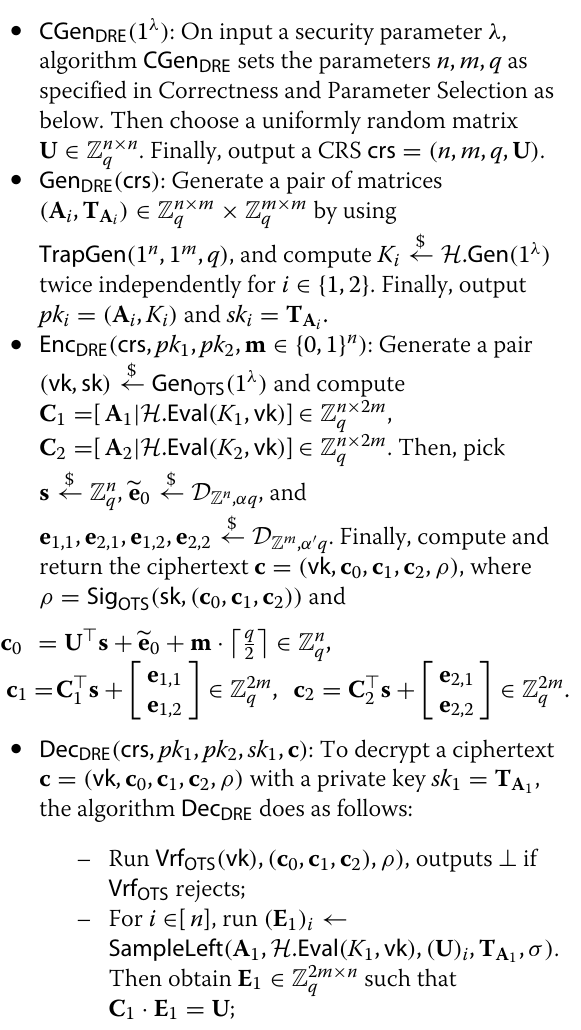
algorithm CGen DRE sets the parameters n , m , q as specified in Correctness and Parameter Selection